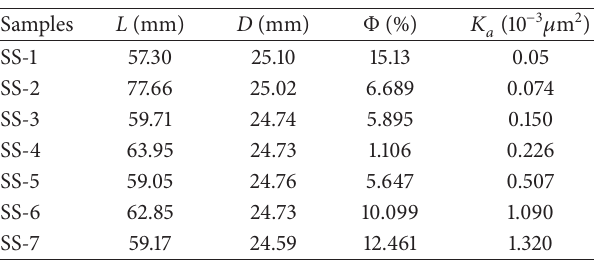
Table 1: Basic parameters of core samples. Samples